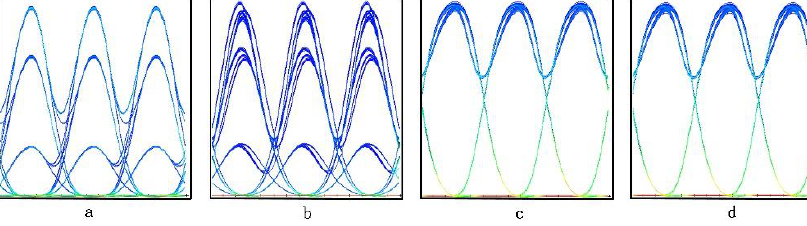
Fig. 4. Eye diagrams of the downlink 67% duty cycle RZ-4PAM and AMI uplink signals before and after